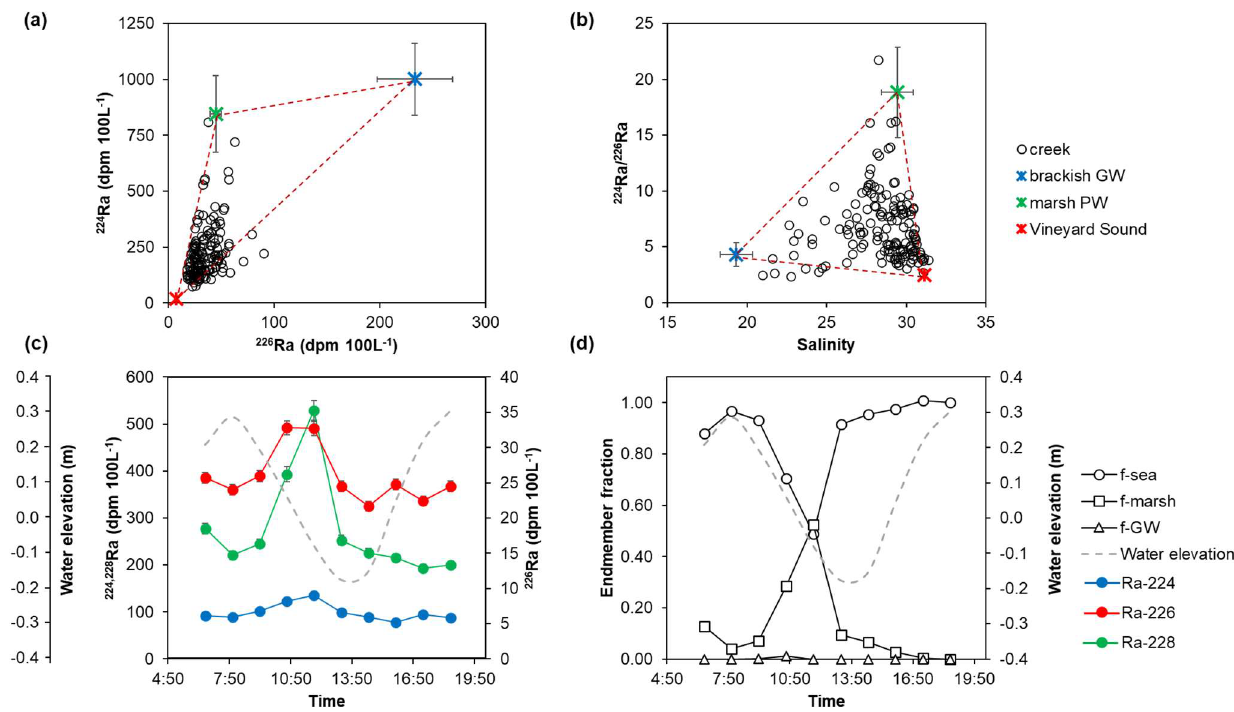
Figure 5. Tidal creek, porewater and groundwater radium isotopes from a microtidal salt marsh (Sage Lot Pond, MA, USA), adapted after Tamborski et al. [6]. Variation in 224 Ra versus 226 Ra ( a ) and 224 Ra/ 226 Ra activity ratios versus salinity ( b ). Hourly variation in Ra activity and creek water elevation during a tidal cycle ( c ) with results of the 224 Ra/ 226 Ra endmember mixing model ( d ). The unique 224 Ra/ 226 Ra ratio of seawater (Vineyard Sound), marsh porewater and brackish groundwaters was used to discriminate between these different pathways to derive endmember fractions of marsh PEX (f-marsh; squares) and brackish SGD (f-GW; triangles).